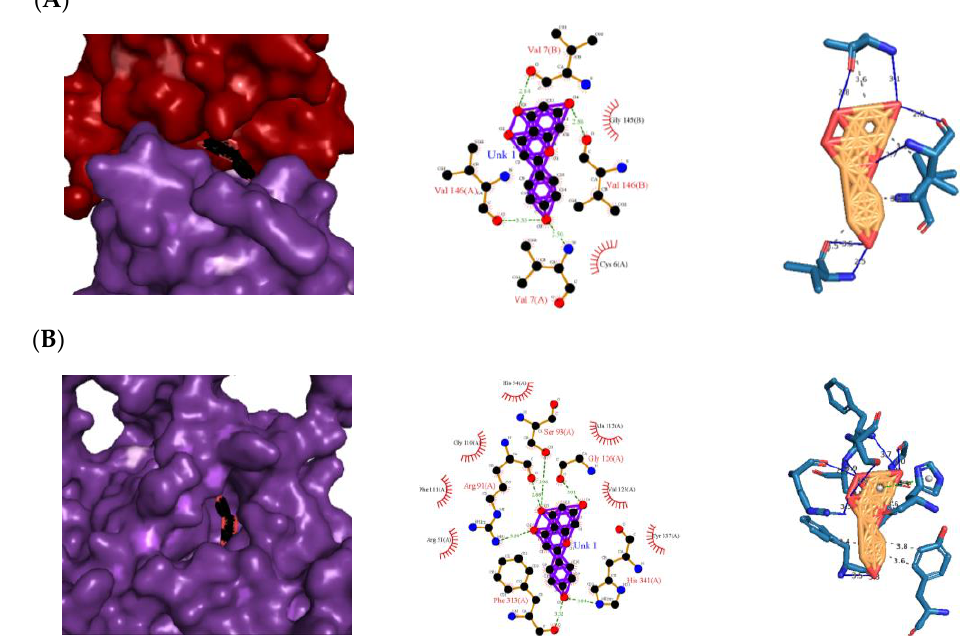
Figure 2. Three-dimensional crystal structures of Copper, ( A ) Zinc Superoxide Dismutase (1CB4); ( B ) Catalase compound II (2CAG); ( C ) Human Glutathione Peroxidase 7 (2P31). The 3D and 2D diagrams of the top ligand docked on the active site for each protein are shown in Figure 3. Naringenin ’ s atoms contributed the following H bonds with the backbones of 1CB4/2CAG (Figure 3A,B): One from the O 2 atom with the backbone of Arg 91(A) in 2CAG; three from the O 3 atom with Val 7(B)/Ser 93(A) and Arg 91(A); two from the O 4 atom with Val 146(B)/Gly 126(A); and four from the O 5 atom with Val 7(A),Val 146(A)/Phe 313(A), and His 341(A). H bonds were considered to be the facilitators of the protein – ligand binding as they displace protein-bound water molecules and facilitate the free-energy barrier reduction during enzyme catalysis [12].